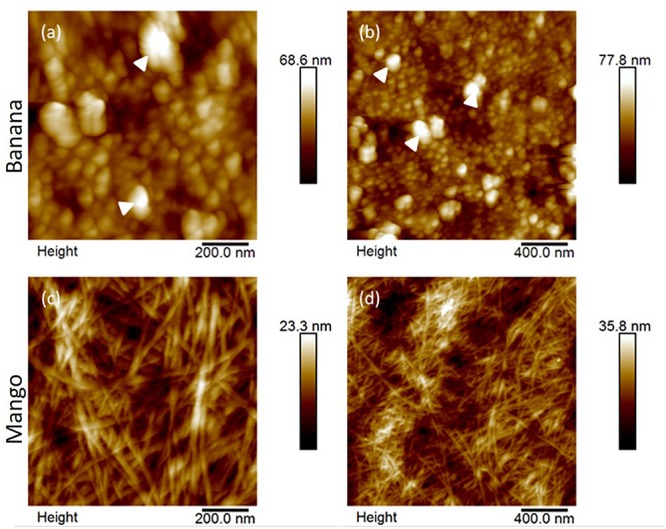
AFM height images of banana (a,b) and mango (c,d) cells at 1 μm (left) and 2 μm (right) scan sizes. Large aggregates on banana cell surfaces are indicated by white arrowheads. In contrast, fibrillar structures, attributed cellulose/hemicellulose are clearly visible in the mango cell wall.